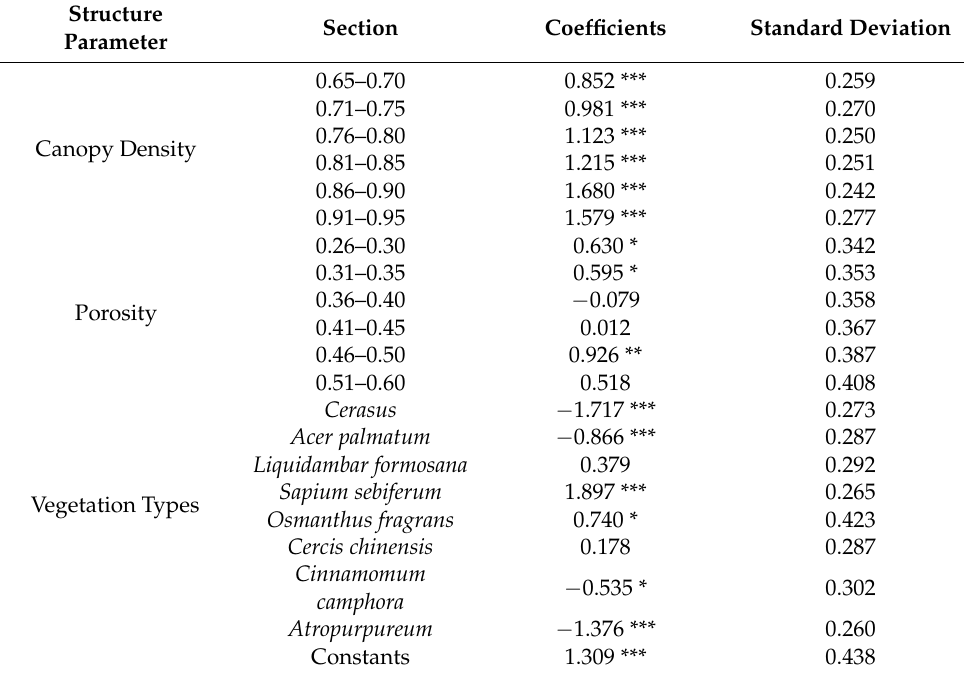
Table 2. Regression analysis on canopy density, porosity, vegetation types and cooling volume.